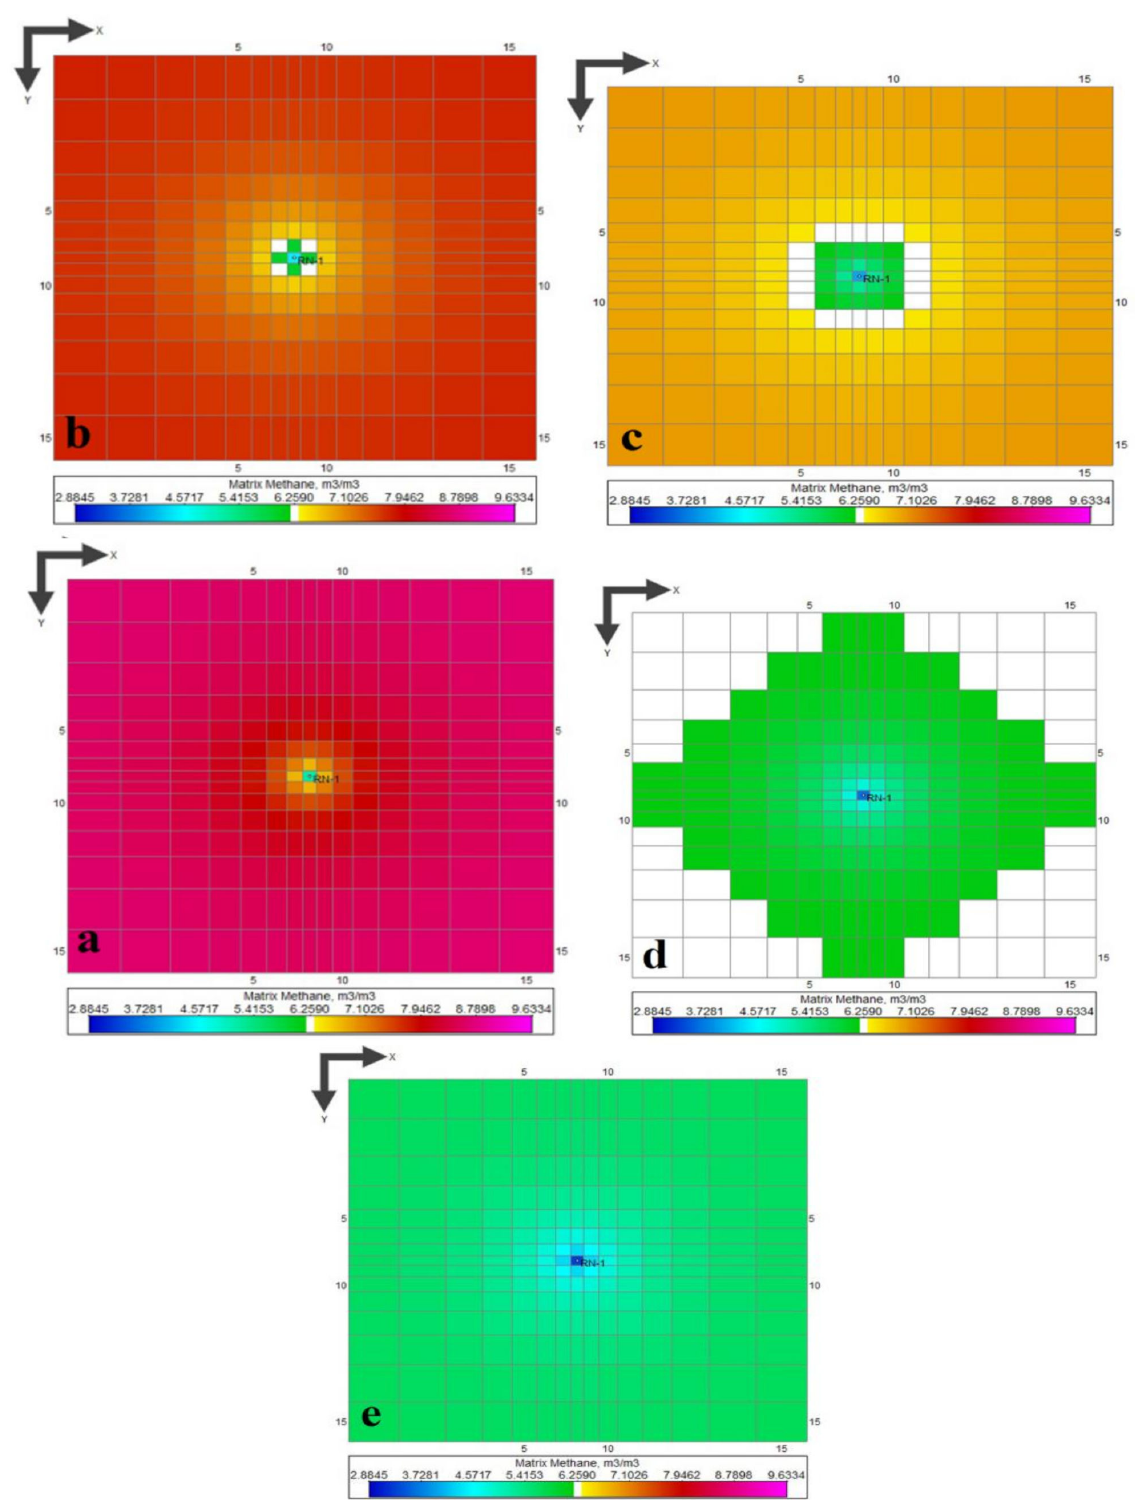
Figure 3. ( a – e ). Matrix methane concentration in the area over a period of 1000 days, 3000 days, 5000 days, 7000 days and 9000 days,